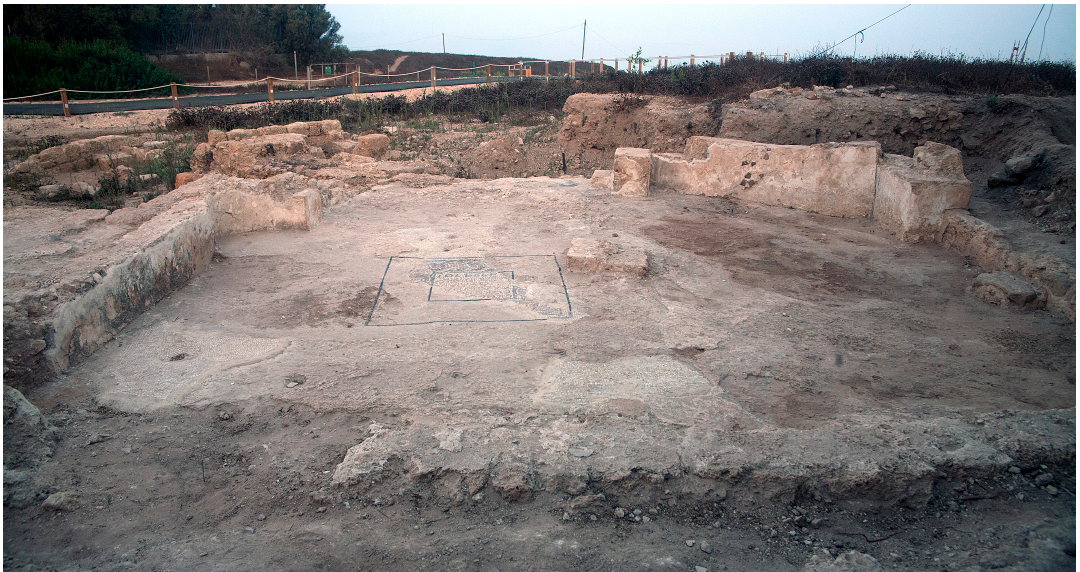
Figure 4. Apollonia-Arsuf, Area P1, F6226, looking southwest (Pavel Shrago).